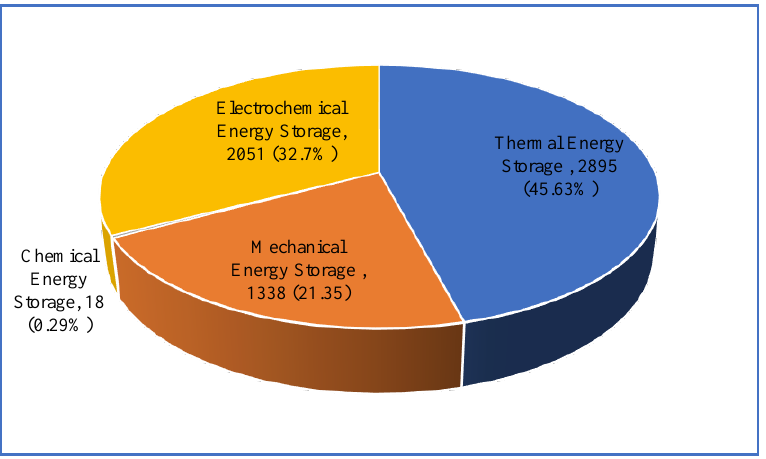
Figure 5. Capacity for the grid-connected operation of various types of energy storage systems.